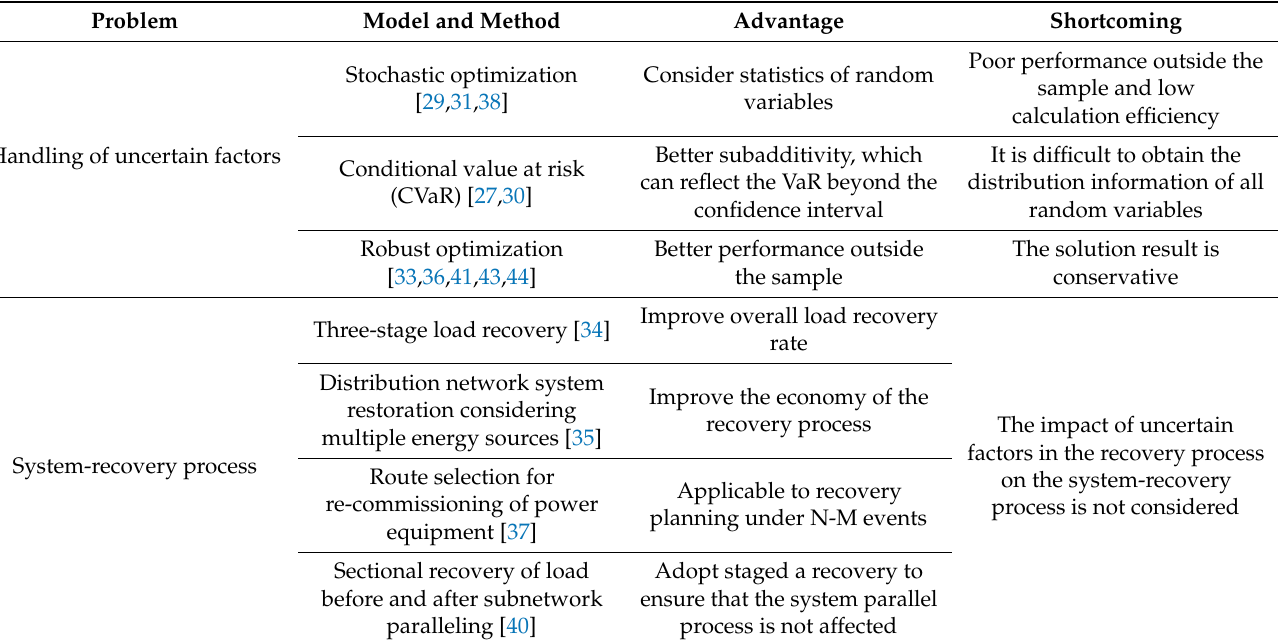
Table 1. Advantages and shortcomings of current